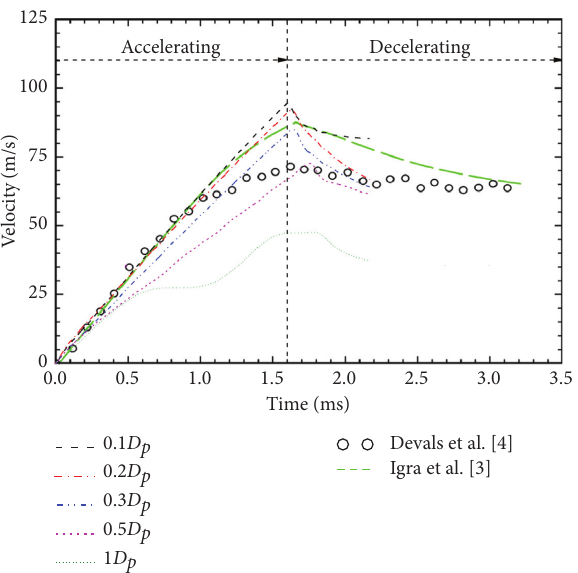
Figure 4: Trajectories of the upstream and downstream fronts of the particles.